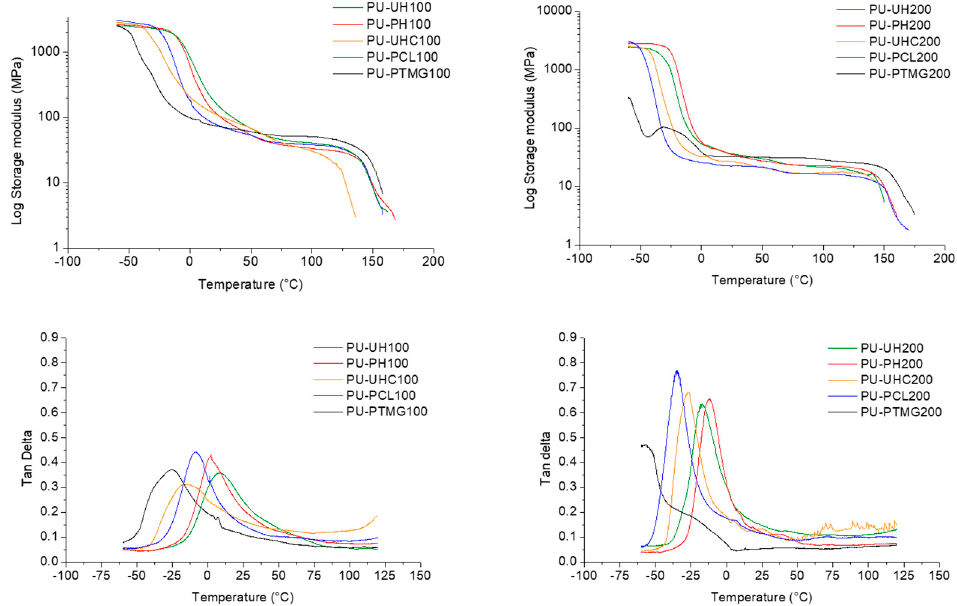
Figure 2. Storage modulus (E’) and tan δ of materials based on polyols with molecular mass equal to 1000 (part a) and 2000 (part b) g/mol.